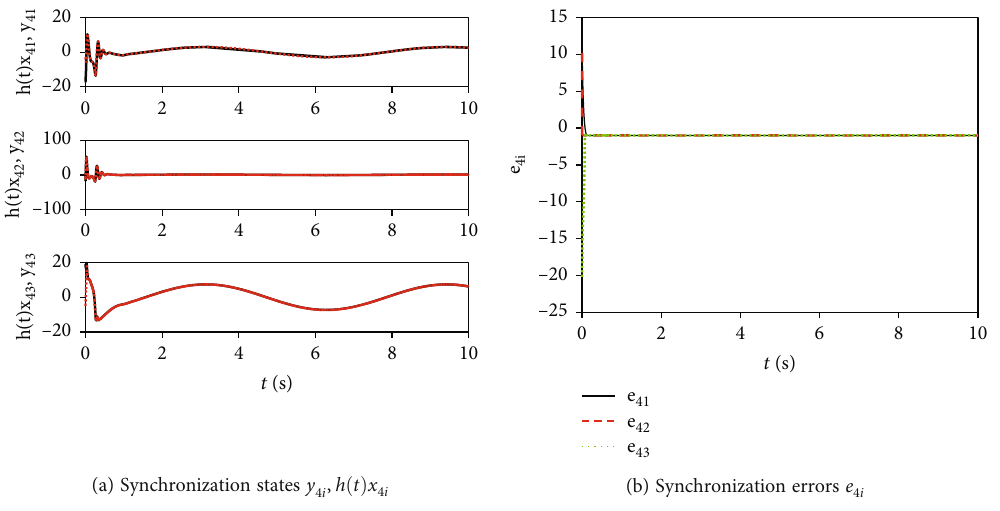
Figure 6: The time evolution of synchronization between y